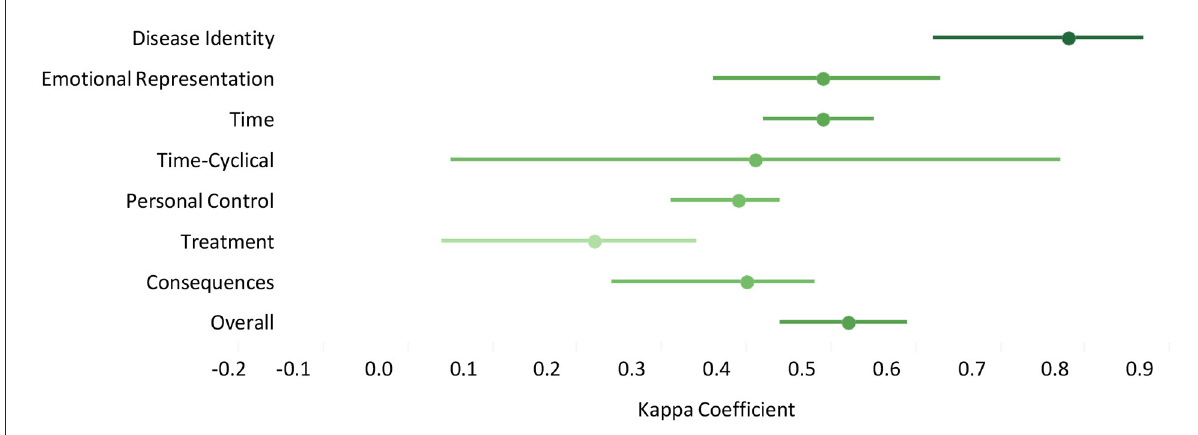
FIGURE2 Kappa co-efficient with 95% confidence interval as determined by test-retest